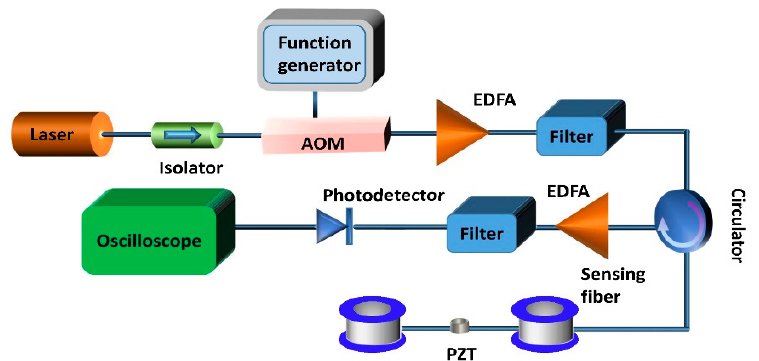
Figure 1. Experimental setup of a phase-sensitive optical time domain reflectometry ( φ -OTDR) system using direct detection. AOM: acoustic optical modulator; EDFA: erbium-doped fiber amplifier.